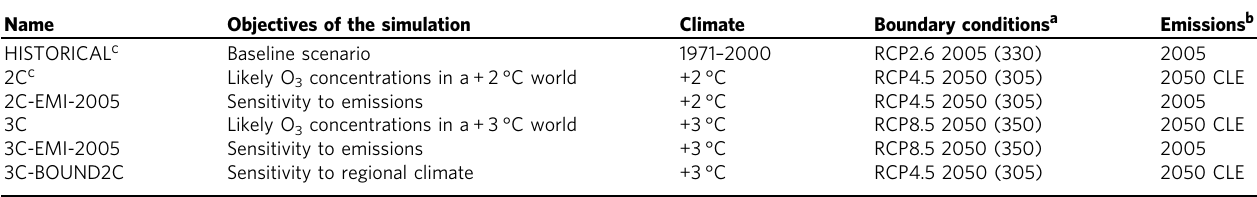
Table 1 Description of the simulations performed by CHIMERE for the different scenarios